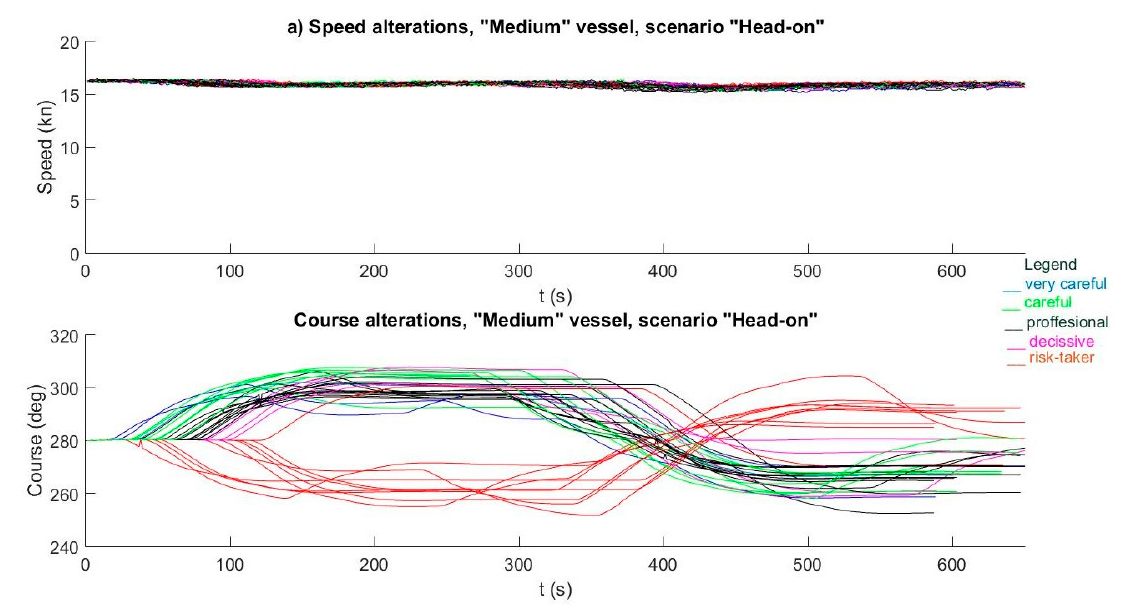
Figure 6. Alterations of speed and course. Medium ship, ‘Head-on’.